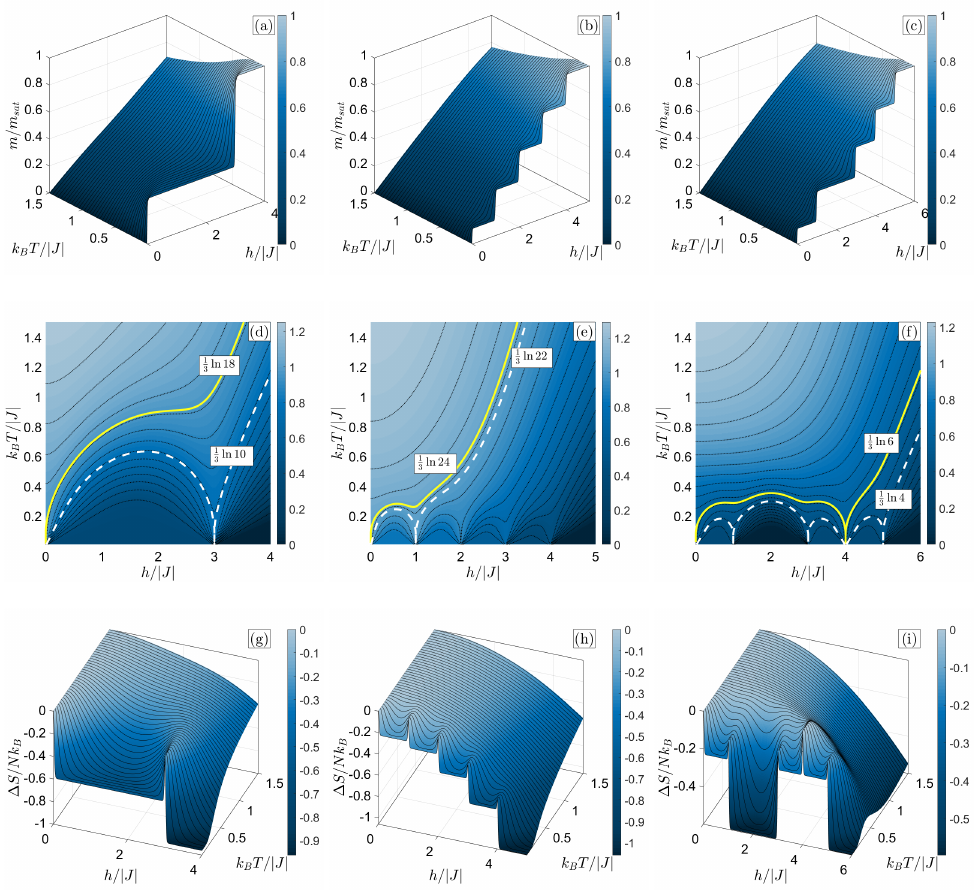
Figure 5. Magnetization ( a – c ), entropy density ( d – f ), and isothermal entropy density change ( g – i ) in k B T / | J | − h / | J | plane, for T cluster with s = 3/2 and D / | J | = 0 ( a , d , g ), D / | J | = − 0.5 ( b , e , h ), D / | J | = − 1 ( c , f , i ). The highlighted isentropes in the middle row correspond to the GS residual entropies at the first two critical fields h c 1 / | J | (solid yellow) and h c 2 / | J | (dashed